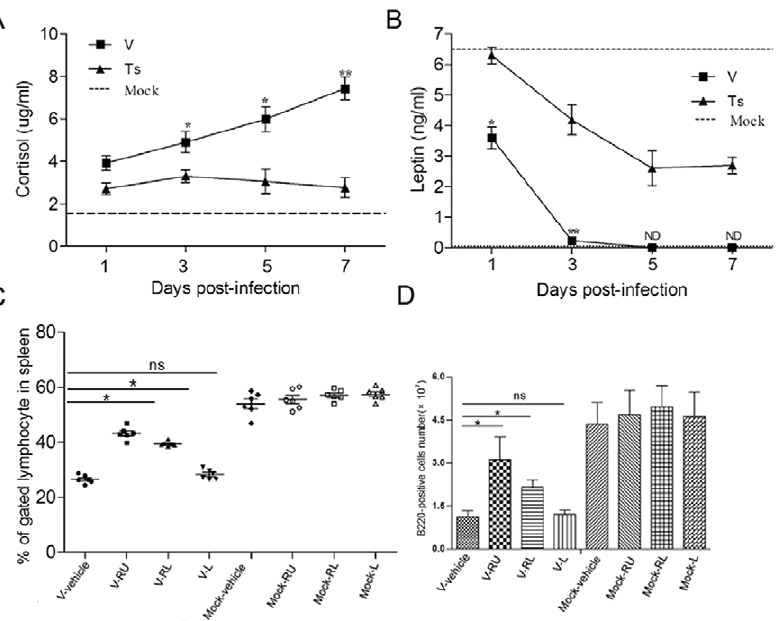
Figure 5. Role of GCs and leptin in depletion of spleen B cells. (A–B) Following infected with V and Ts virus, plasma from mice was prepared at different time points. Cortisol and leptin levels in plasma were measured using ELISA. Baseline from PBS inoculated mice (n=5) is shown as a dashed line in each graph. ND means the examination is lower than the limit of detection. Data represent means of three mice per group per time point 6 SD. * p , 0.05 and ** p , 0.01 between V and Ts. (C–D) The mice were divided for four groups (12 mice/group) and inoculated i.p. respectively with 2% ethyl alcohol (vehicle), RU486 (R), RU486 plus leptin (RL), leptin (L) from day 2 1 p.i. and until the end of experiment. Each group was divided for two groups (6 mice/group) again, and one group was infected i.n. with 10 4 PFU of V (V-) and another was infected i.n. with PBS (Mock-). The spleen cells were prepared on day 5 post-infection and stained. The percentages (C) each group were evaluated by flow cytometry, and the numbers (D) were calculated by multiplying the percentage of each cell type by the total number of spleen viable cells. Data shown in C and D represent means of 6 mice from each group 6 SD. Ns mean no statistical difference between both. * p , 0.05 and ** p , 0.01 between V-vehicle and V-R or V-RL or V-L.